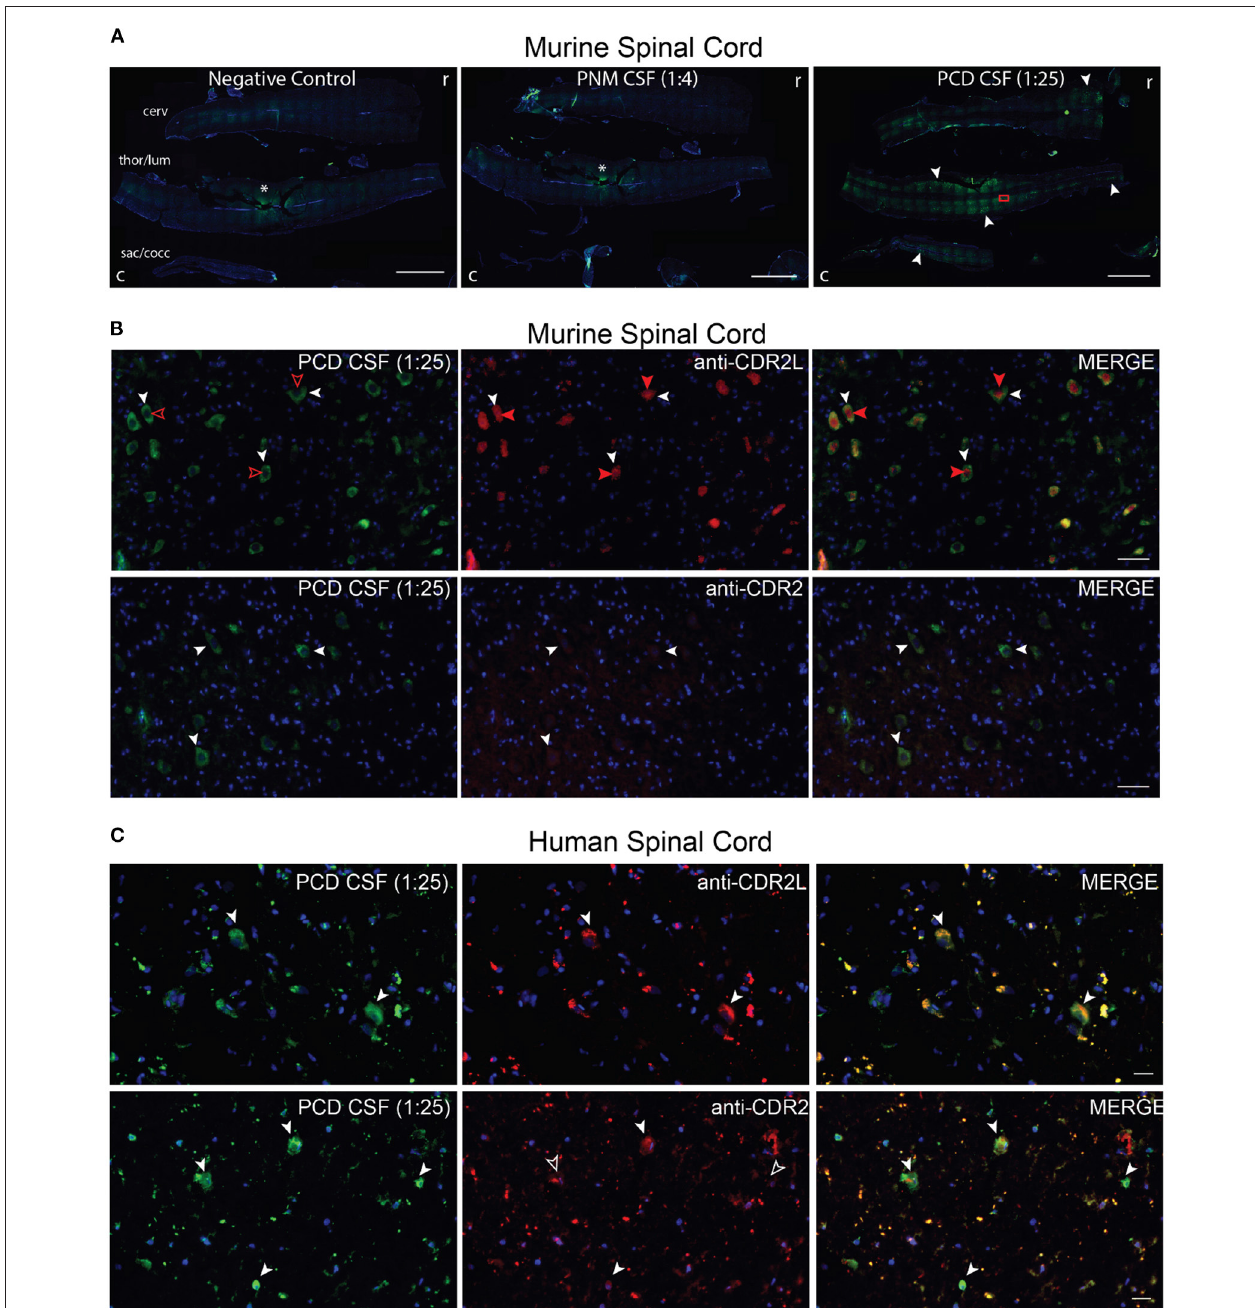
FIGURE 4 | PNM CSF, PCDF CSF, CDR2L and CDR2 immunostaining of spinal cord. (A) Cervical (cerv), thoracolumbar (thor/lum), sacrococcygeal (sac/cocc) murine spinal cord was immunostained with PNM CSF (1:4) or PCD CSF (1:25). The rostral (r) and caudal (c) ends are on the right and left of each image, respectively. PNM CSF did not immunostain murine spinal tissue above background (asterisk = tissue artifact also seen in the negative control). PCD CSF immunostained cells along the longitudinal axis of the spinal cord (filled arrows). The red rectangle indicates the approximate region of images shown in (B) . Scale bars = 2,000 µ m. (B) Coimmunostaining of murine spinal cord with PCD CSF (1:25) and anti-CDR2L or anti-CDR2. PCD CSF and anti-CDR2L immunostained the cytoplasm of large cells and colocalized with cytoplasmic anti = CDR2L immunostaining (white arrowheads). However, anti-CDR2L also immunostained nuclei (filled red arrows) but PCD CSF did not (unfilled red arrowheads). Scale bars = 200 µ m. (C) Coimmunostaining of human spinal cord with PCD CSF. PNM CSF failed to immunostain human spinal cord (not shown). PCD CSF immunostained sparse cells that were also CDR2L positive (top row, white arrowheads). In the lower row, PCD CSF cells are costained by anti-CDR2L (white arrowheads). In the lower row, only some cells immunostained by PCD CSF were also immunostained by anti-CDR2 (filled arrow heads, co-stained cells; unfilled, PCD CSF exclusive cells). Scale bars = 20 µ m.